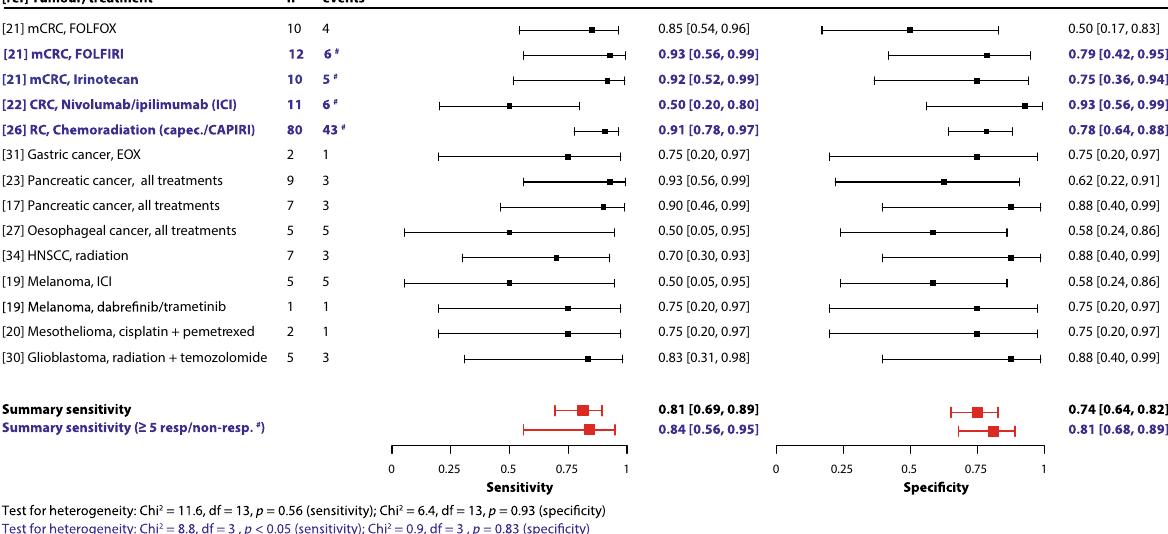
Fig. 3 Forest plots of sensitivity and speci fi city (clinical validity pooled results). A paired forest plot of the sensitivity and speci fi city of each study and treatment type is shown with 95% con fi dence intervals. A bivariate meta-analysis was performed to obtain a pooled summary estimate for sensitivity and speci fi city indicated in the forest plots (1: for all studies that reported results that could be included in this pooled analysis and 2: for studies with ≥ 5 responders/non-responders). The analysis was performed in R (Version 3.6.1) using the “ mada ” package 51 . In blue and bold font ( # ) the studies were indicated which were included in the analysis for ≥ 5 responders/non-responders. Patients who contributed to multiple accuracy estimates: 2 patients received ICI and dabre fi nib/trametinib 19 ; 3 patients received FOLFOX and irinotecan- based treatment 21 ; 3 patients had 2 PDOs each (before and after FOLFOX treatment) 21 and 1 patient had a synchronous tumour (responder and non-responder) 22 . Abbreviations: capec . capecitabine, CAPIRI capecitabine + irinotecan, df degrees of freedom, EOX epirubicin + oxaliplatin + 5-FU, FOLFIRI 5- fl ouruoracil + irinotecan, FOLFOX 5- fl uorouracil + oxaliplatin, HNSCC head & neck squamous cell carcinoma, ICI immune checkpoint inhibitors, mCRC metastatic colorectal cancer, RC rectal cancer, ref reference, resp. responder clinically, non-resp . non- responder